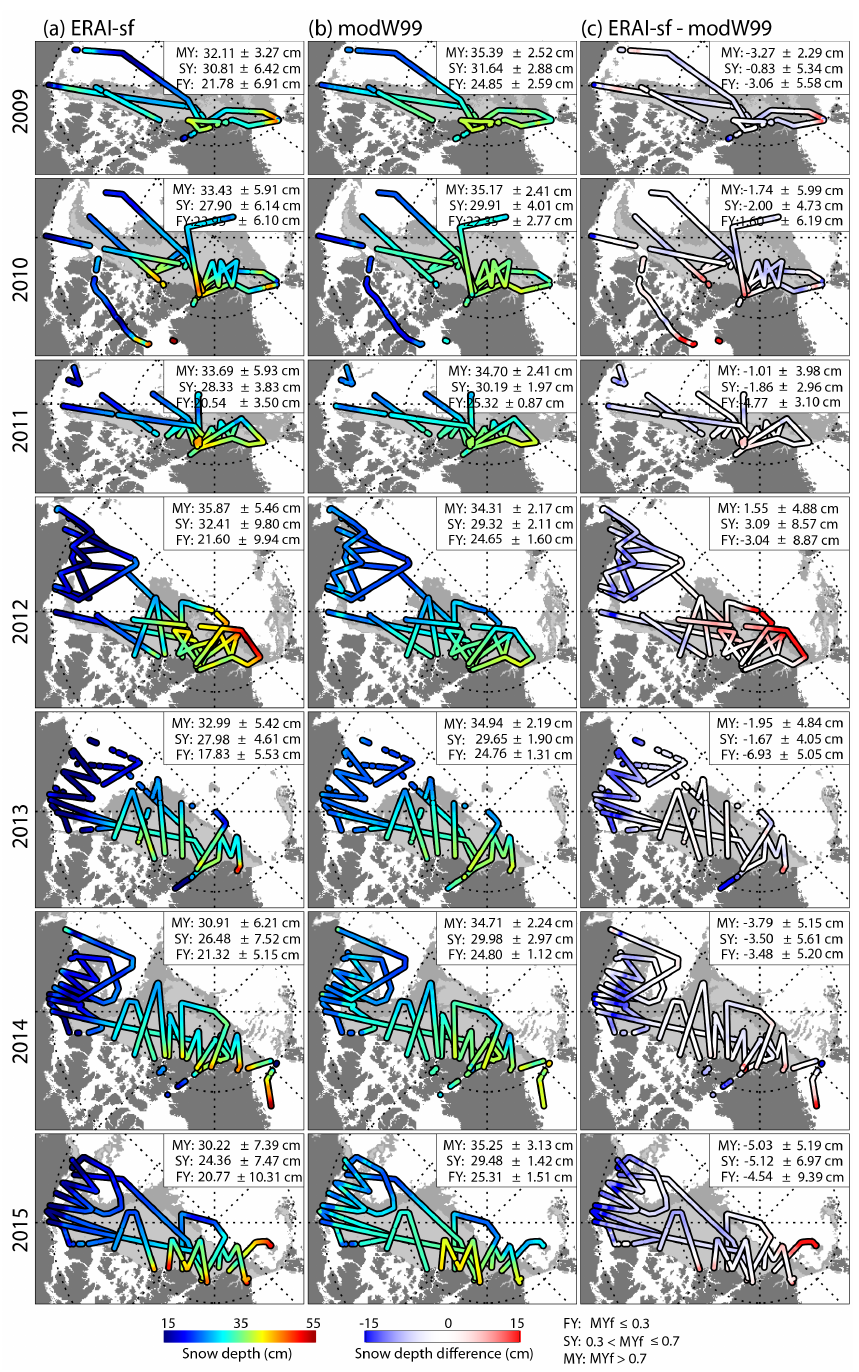
Figure 10. Comparison of snow depth from ERAI-sf and modW99 climatology at the snow-radar tracks: (a) ERAI-sf, (b) modW99, and (c) difference between (a) and (b) . The mean and standard deviation in each of the three categories of MYf are shown on the top-left corner of each